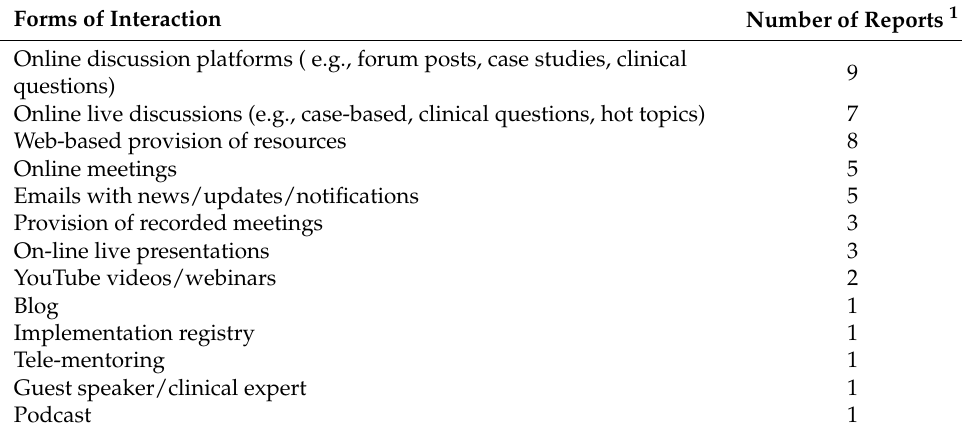
Table 4. VCoP forms of